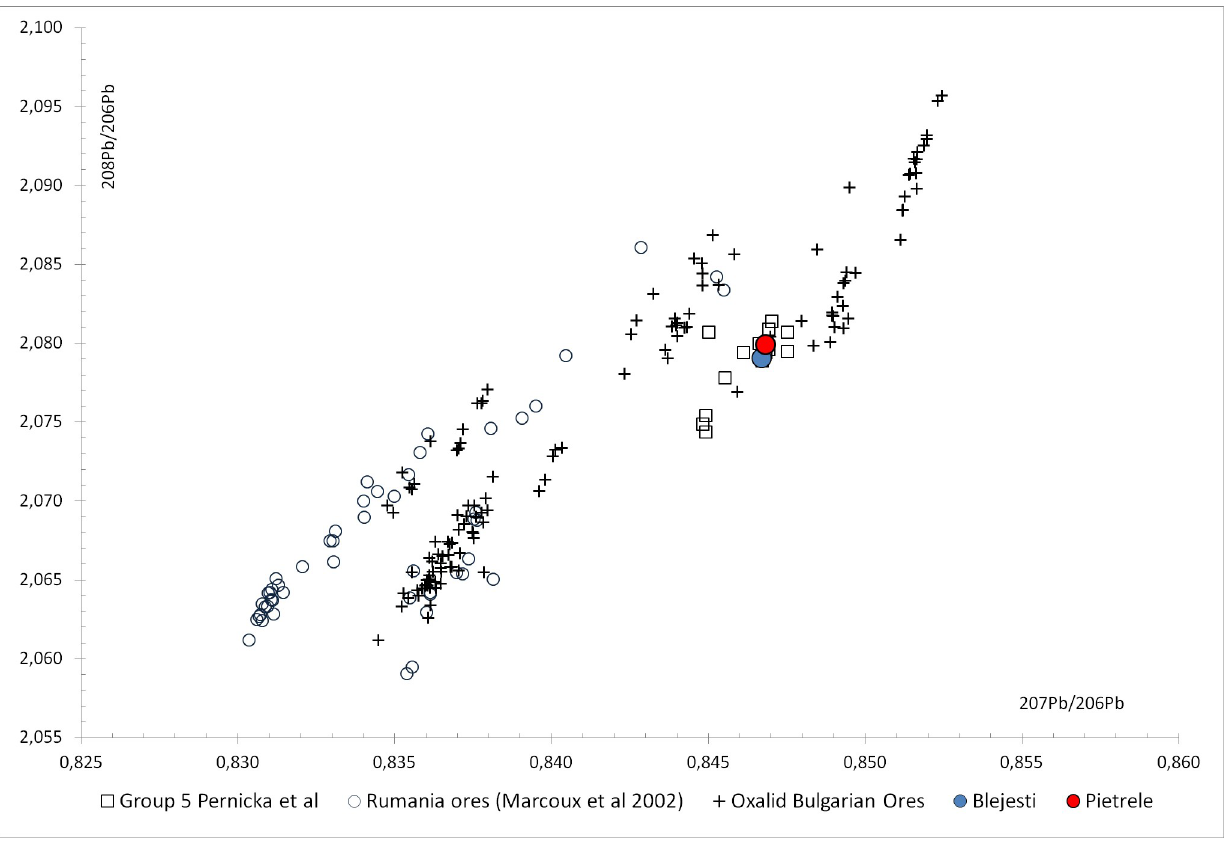
Fig 24. Lead isotope ratios of Bleje ş ti 1–2 and Pietrele P06F3741096 samples compared with Romanian ores by [42], Bulgarian ores by [44] and Bulgarian metal group 5 by [43] (I. Montero).